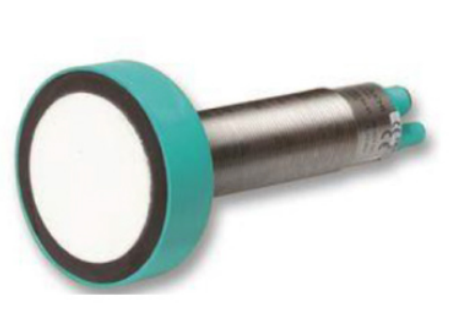
Figure 6. ETG ultrasound sensor (Table 1).